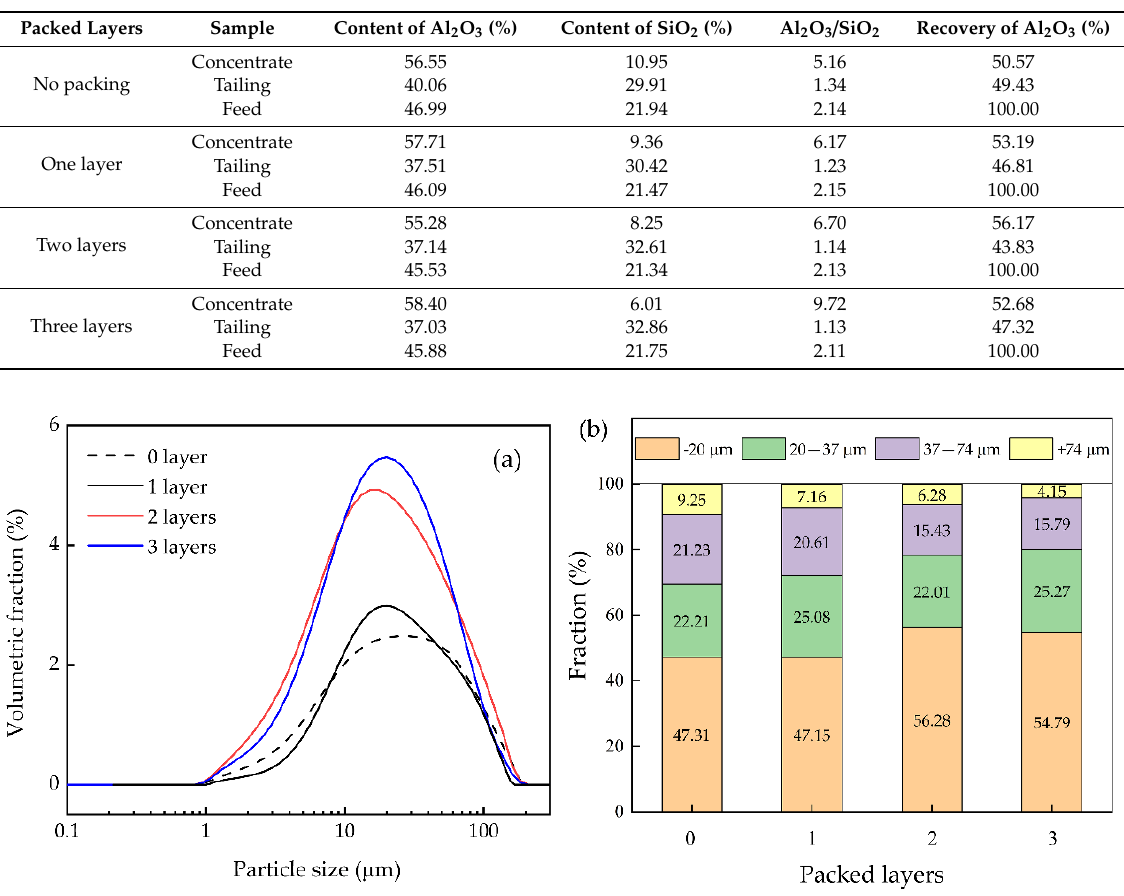
Figure 5. Particle-size distribution of the flotation concentrates obtained with different packing layers: ( a ) Volumetric fraction; ( b ) Cumulative fraction at specific value.